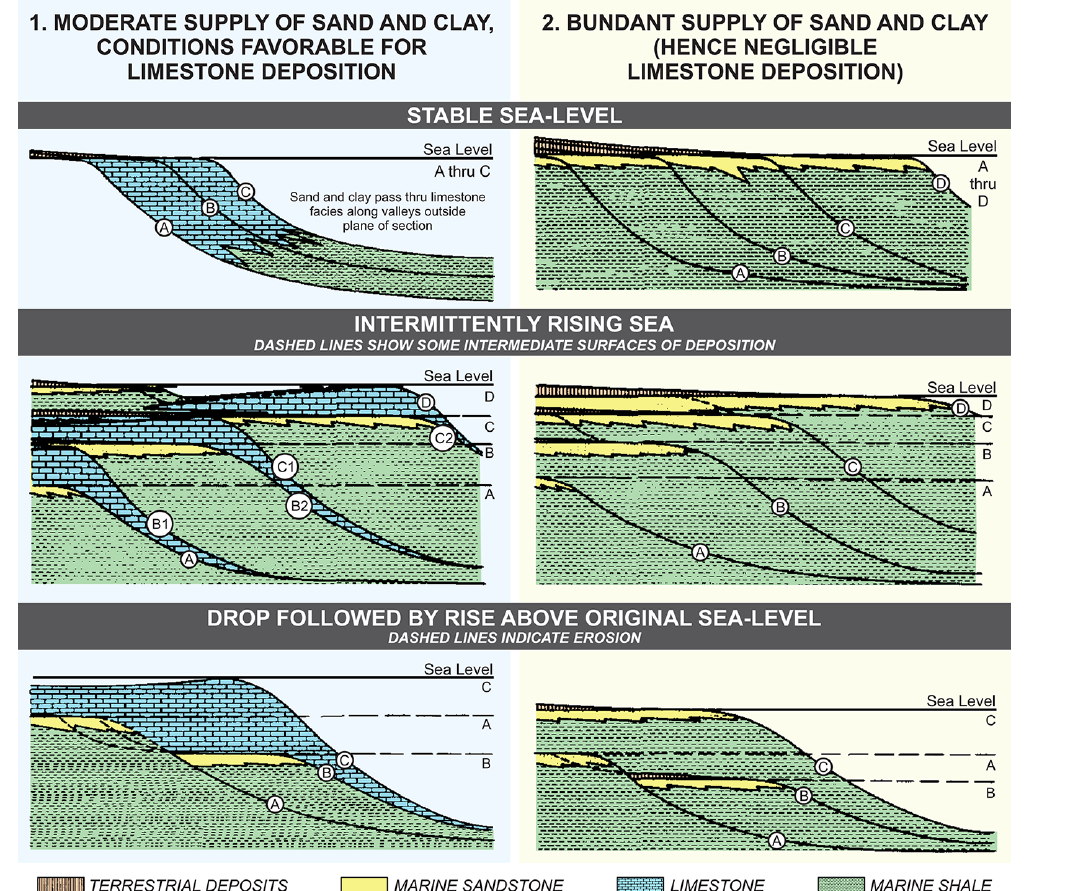
Figure 22. Different scenarios where sea-level changes and sediment supply cause different geometries and lithological compositions in continental margin deposition (modified from Van Siclen,